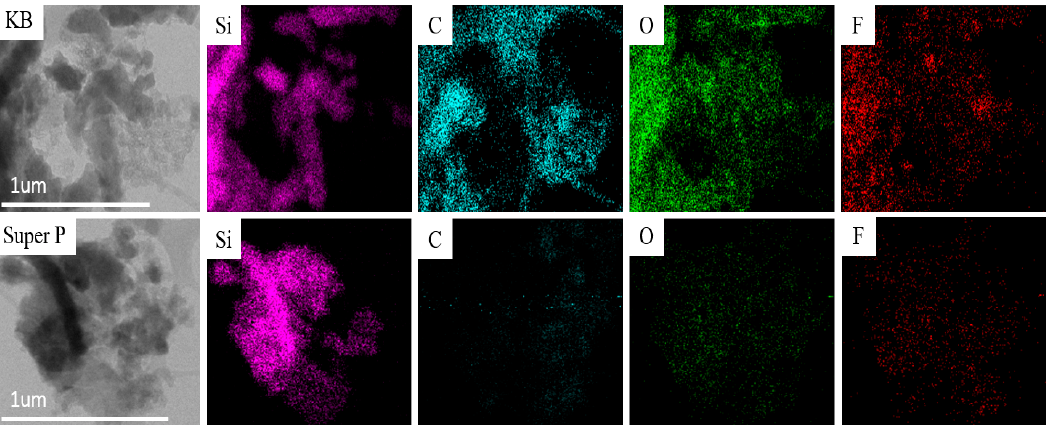
Figure 9. TEM images and EDS mappings of the Si-based anode with KB and that with Super P as conductivity enhancement additives.